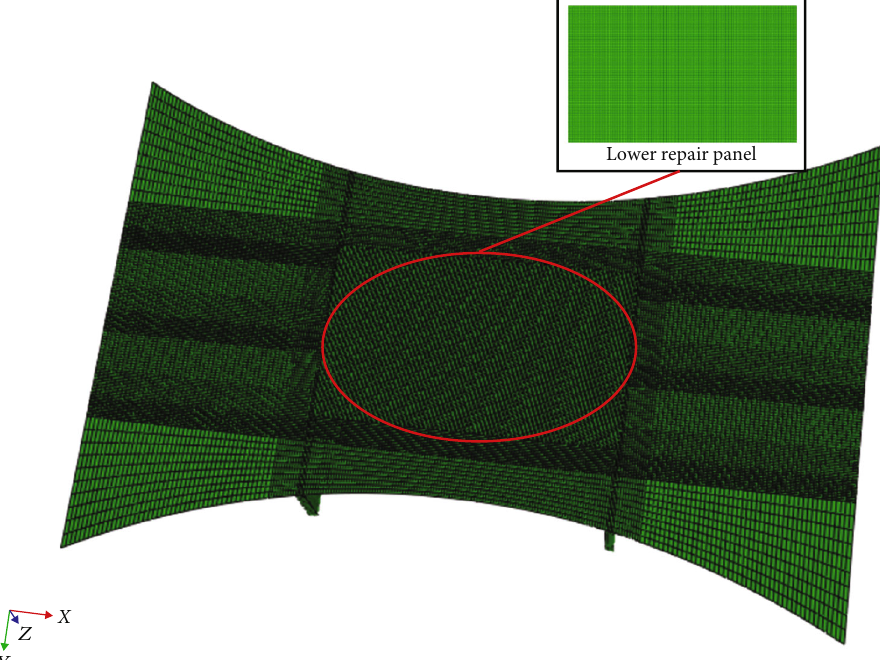
Figure 6: Repaired panel ’ s mesh model (lower view).